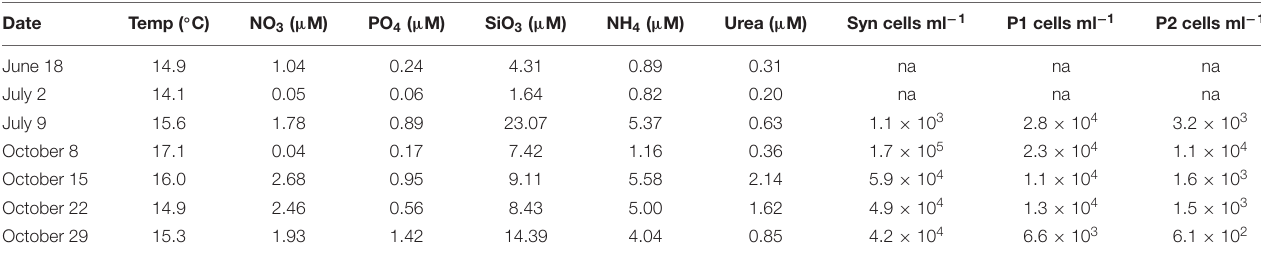
TABLE 1 | Environmental data for each sampling date and cell abundances as determined by flow cytometry for Syn ( Synechococcus ), P1 (photosynthetic picoeukaryotes with size ∼ < 3 µ m beads) and P2 (photosynthetic picoeukaryotes with size ∼ > 3 µ m